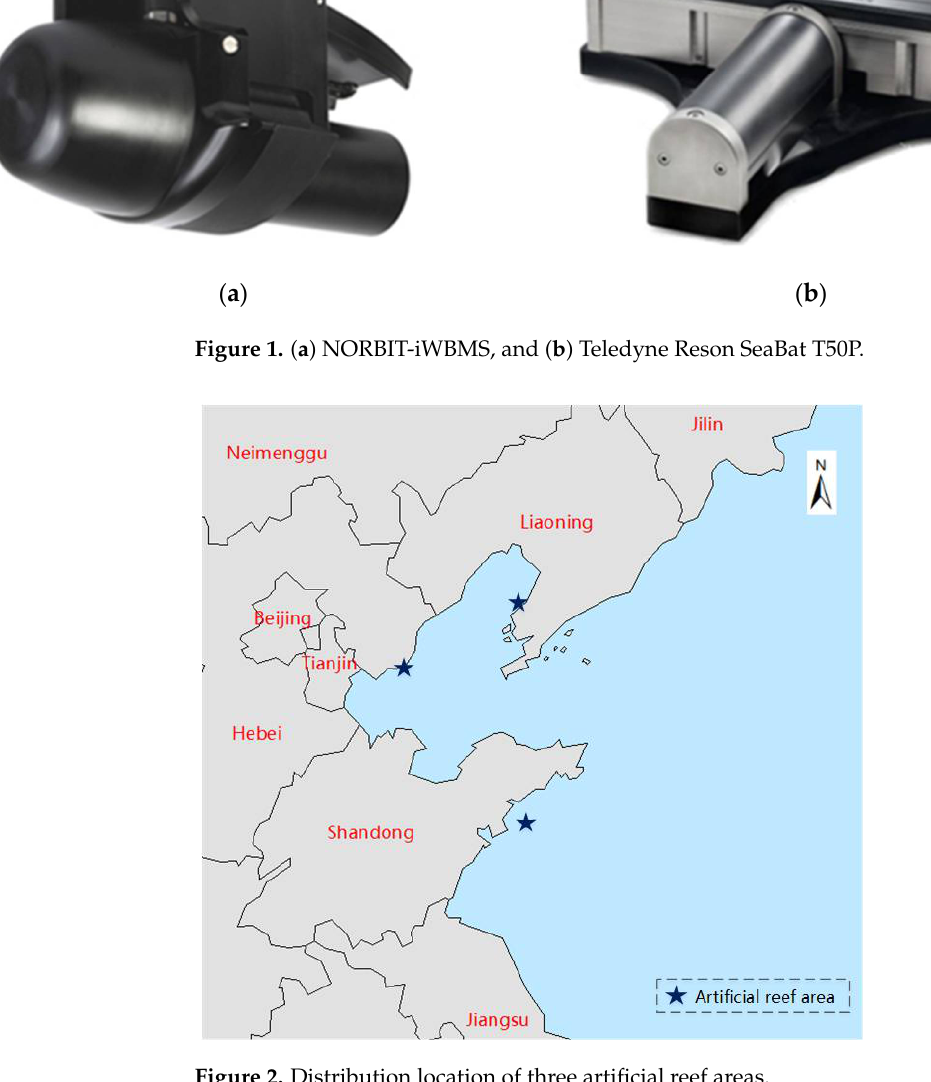
Table 1. Detailed information for the NORBIT-iWBMS and Teledyne Reson SeaBat T50P.